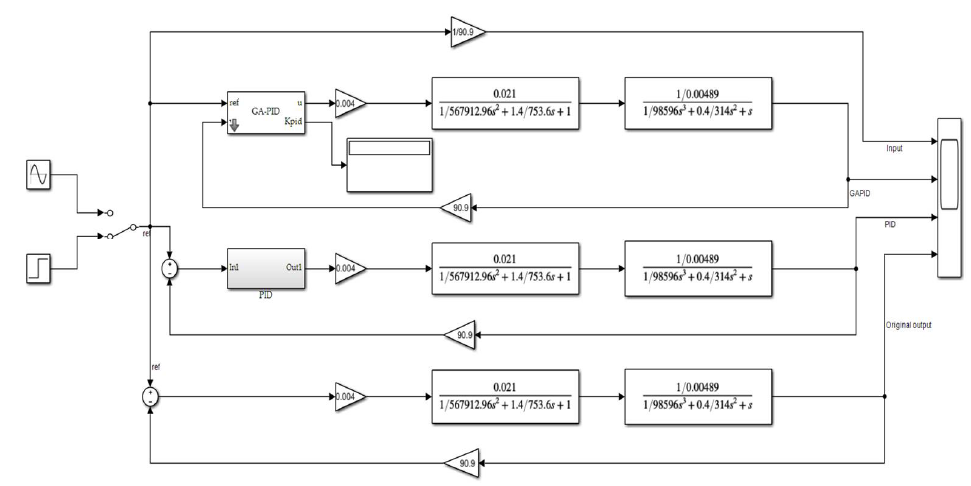
Figure 8. Optimization of PID simulation diagram by GA.